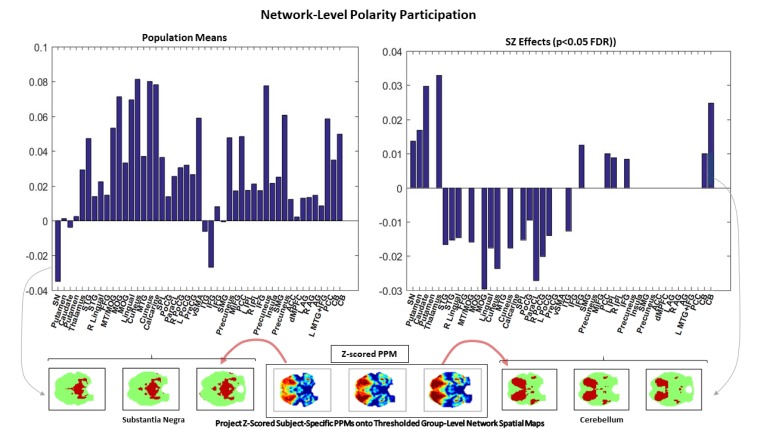
Network level polarity participation; network-level polarity participation population means (top left); significant SZ effects (p<0.05 (FDR)) on network level polarity participation (top right); schematic (bottom) showing three axial slices of the z-scored population averaged PPM (bottom middle) and the same three axial slices of the binarized thresholded group-level cerebellum GICA spatial map (bottom right) and the group-level GICA substantia negra (bottom left) illustrating how PPM projection onto thresholded substantia negra presents negative network-level polarity participation and PPM projection onto thresholded cerebellum presents positive network-level polarity participation.